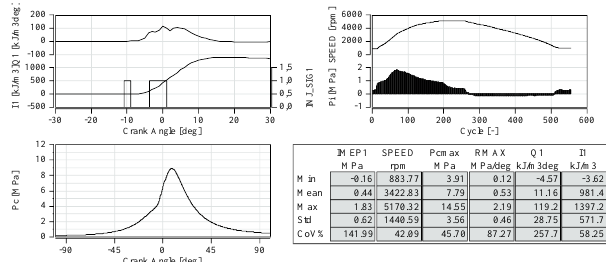
Fig. 15. The vehicle acceleration in the second gear with the throttle open at maximum, with diesel fuel with the addition of hydrogen; The courses of developing heat (Q1) and amount of developed heat (I1), mean indexed pressure (IMEP1) are